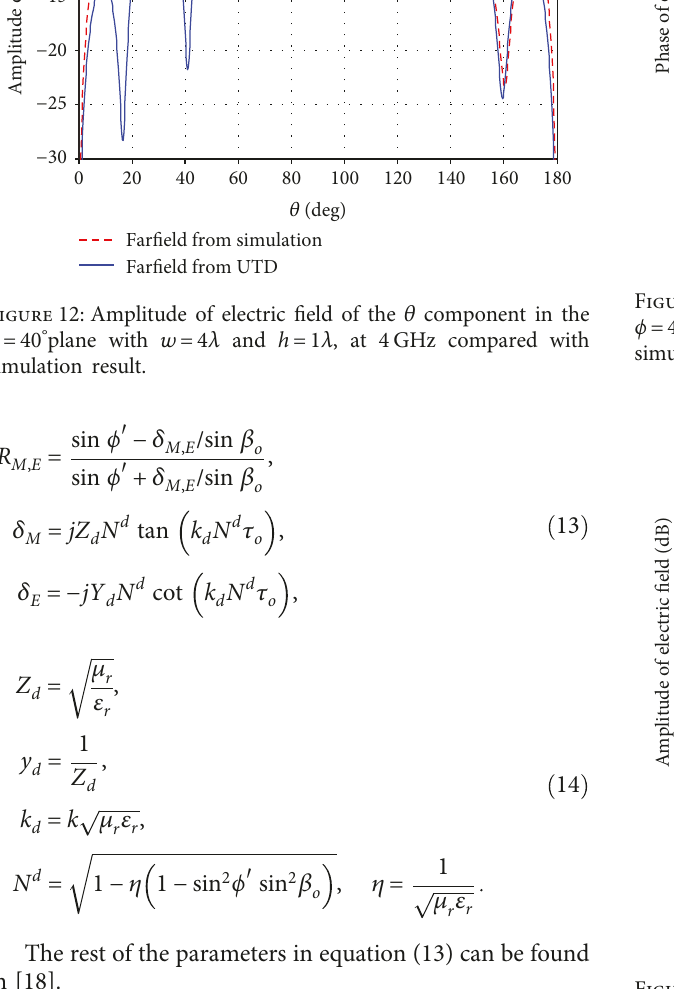
Figure 14: Amplitude of electric fi eld of the ϕ component in the ϕ =40 ° plane with w =4 λ and h =1 λ , at 4GHz compared with simulation